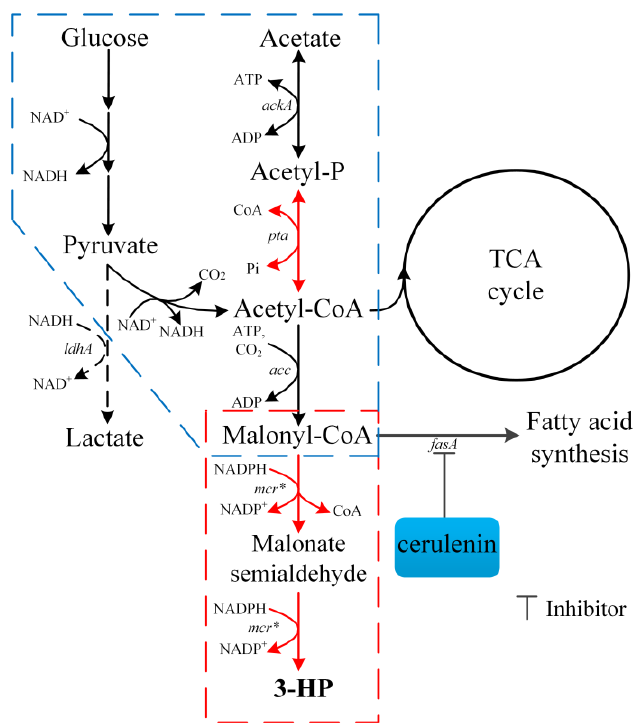
Figure 1. The 3-HP biosynthesis pathway of C. glutamicum . Black arrows indicate the native pathways of C. glutamicum , black dashed lines indicate deleted pathways, red arrows indicate genes which were overexpressed or introduced, the red dashed box shows the malonyl-CoA reduction module, and the blue dashed box shows the malonyl-CoA synthesis module. Acetyl-P, acetyl phosphate; 3-HP, 3-hydroxypropionic acid; ldhA , lactate dehydrogenase A; ackA , acetate kinase A; pta , acetyl phosphate transferase; acc , acetyl-CoA carboxylase; mcr , malonyl-CoA reductase; fasA , fatty acid synthetase A.